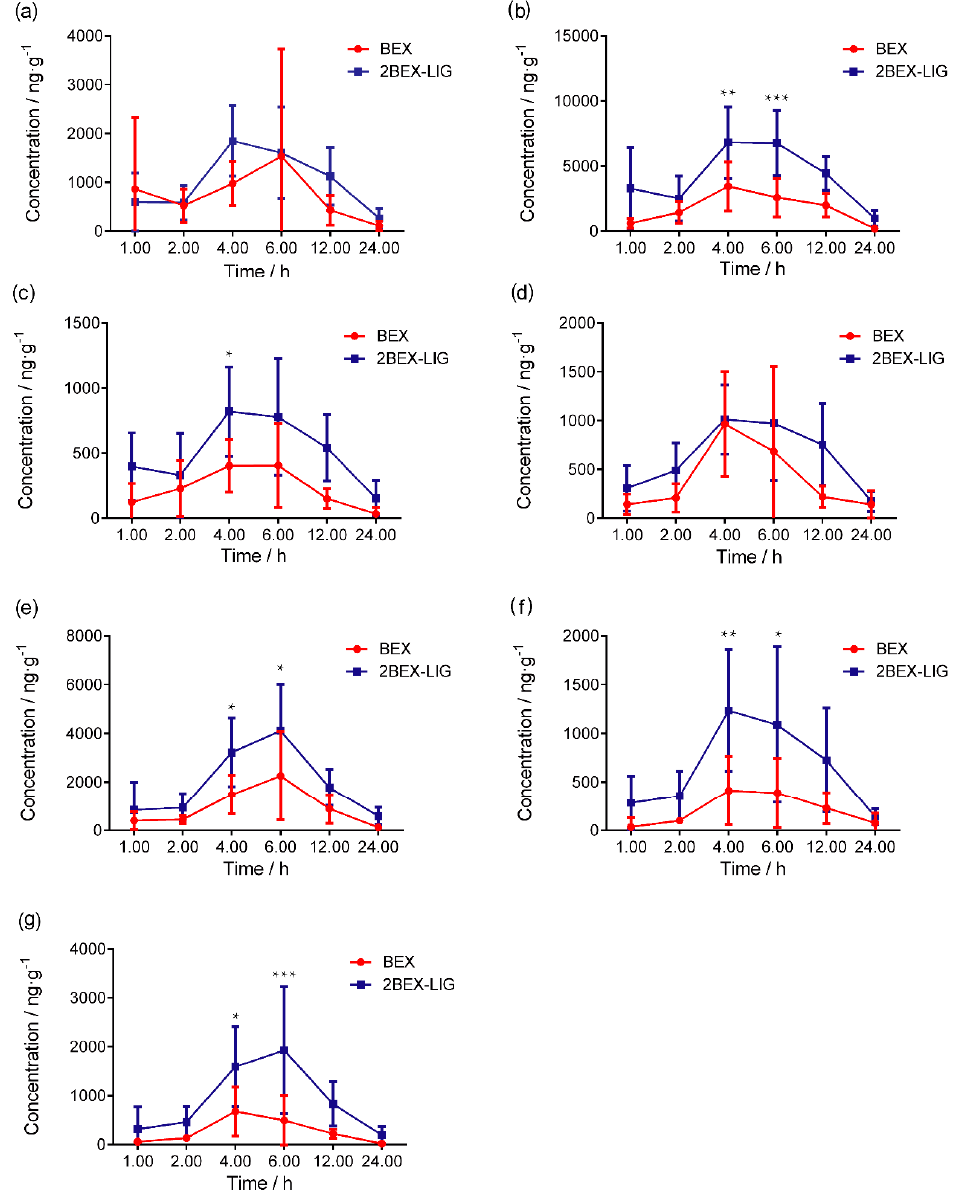
Figure 9. The concentration of bexarotene (BEX) in tissues of SD rats orally administrated BEX (30 mg / kg) and 2bexarotene-ligustrazine (2BEX-LIG) (equivalent to 30 mg / kg BEX) at 1, 2, 4, 6, 12, and 24 h in ( a ) the heart; ( b ) the liver; ( c ) the spleen; ( d ) the lungs; ( e ) the kidneys; ( f ) the cortex; and ( g ) others (brain) . ( n = 6). * p < 0.05, ** p < 0.01, and *** p < 0.001 vs. BEX.